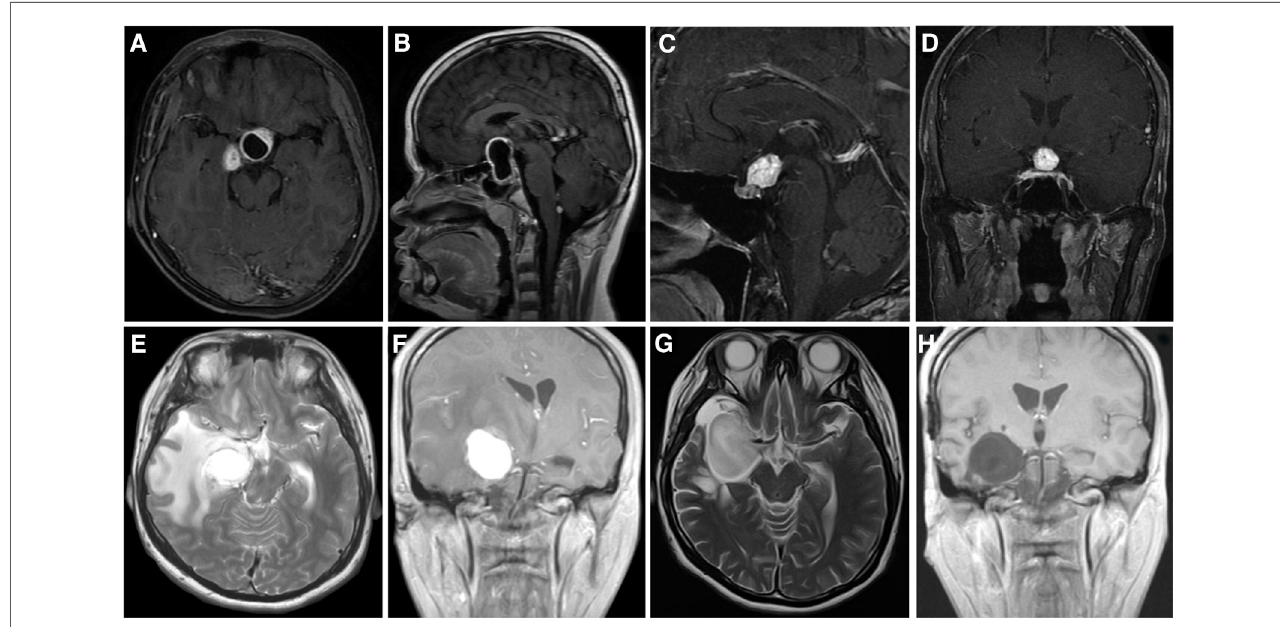
FIGURE 3 Imaging data of Xiangya cases. ( A,B ) Case 1: Cystic hemangioblastoma in the sellar region. ( C,D ) Case 3: Solid hemangioblastoma in pituitary stalk. Case 7: Solid hemangioblastoma in the basal ganglia region accompanied by massive edema ( E,F ), the edema subsided completely 3 weeks after operation ( G ), and there was no recurrence 26 months after operation ( H ).